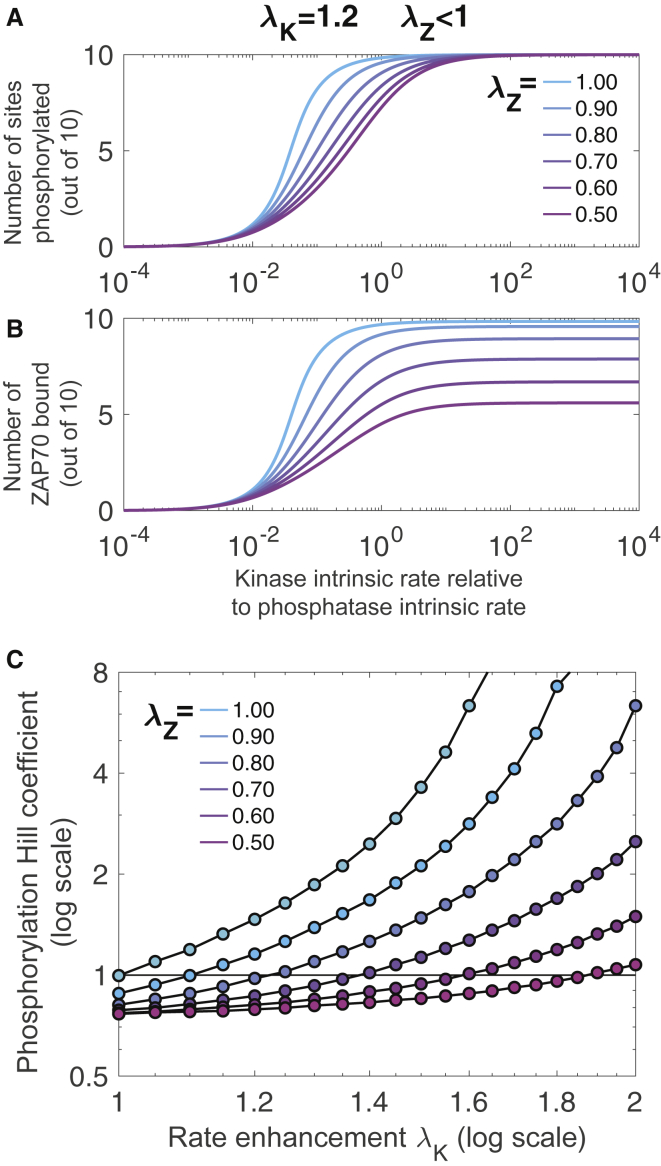
Integrative model shows counteracting effects of rate enhancement and rate reduction. Rate reduction from ZAP70 binding (λZ < 1 indicated by color) abrogates the switch-like dose response conferred by rate enhancement of kinase phosphorylating TCR λK = 1.2 for both amount of phosphorylation (A) and amount of ZAP70 bound (B), in addition to reducing the saturating value (Emax) of ZAP70 binding (B). (C) Ultrasensitivity quantified using the log-effective-concentration definition of Hill coefficient (Eq. S2) is shown for a range of λK ≥ 1 and λZ ≤ 1. To see this figure in color, go online.